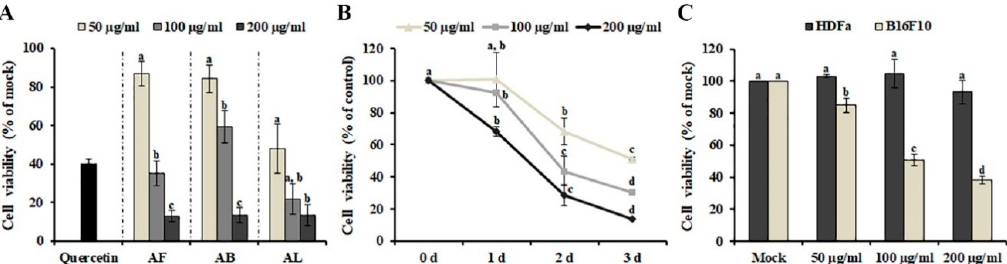
Figure 1. Anti-melanoma effect of methanol extracts obtained from Abeliophyllum distichum leaves (AL), fruit (AF), and branches (AB). ( A ) Effect of A. distichum organ extracts on the cell viability of SK-MEL-2 cells. SK-MEL-2 cells were treated with different concentrations of each extract for 48 h, and cell viability was determined using MTT [3-(4,5-dimethylthiazol-2-yl)-2,5-diphenyltetrazolium bromide] assay. 10 μ M of Quercetin was used as positive control. ( B ) Time and dose dependence of the anti-melanoma effect induced by AL. ( C ) Effect of AL on the cell viability of B16F10 murine melanoma cells and HDFa human dermal fibroblast cells. B16F10 cells and HDFa cells were treated with the indicated doses of AL for 48 h, and the viabilities of the cells were determined. The values are the means of three independent experiments, and the error bars represent the standard error. Values in the same column with different superscript letters are significantly different ( p < 0.05).